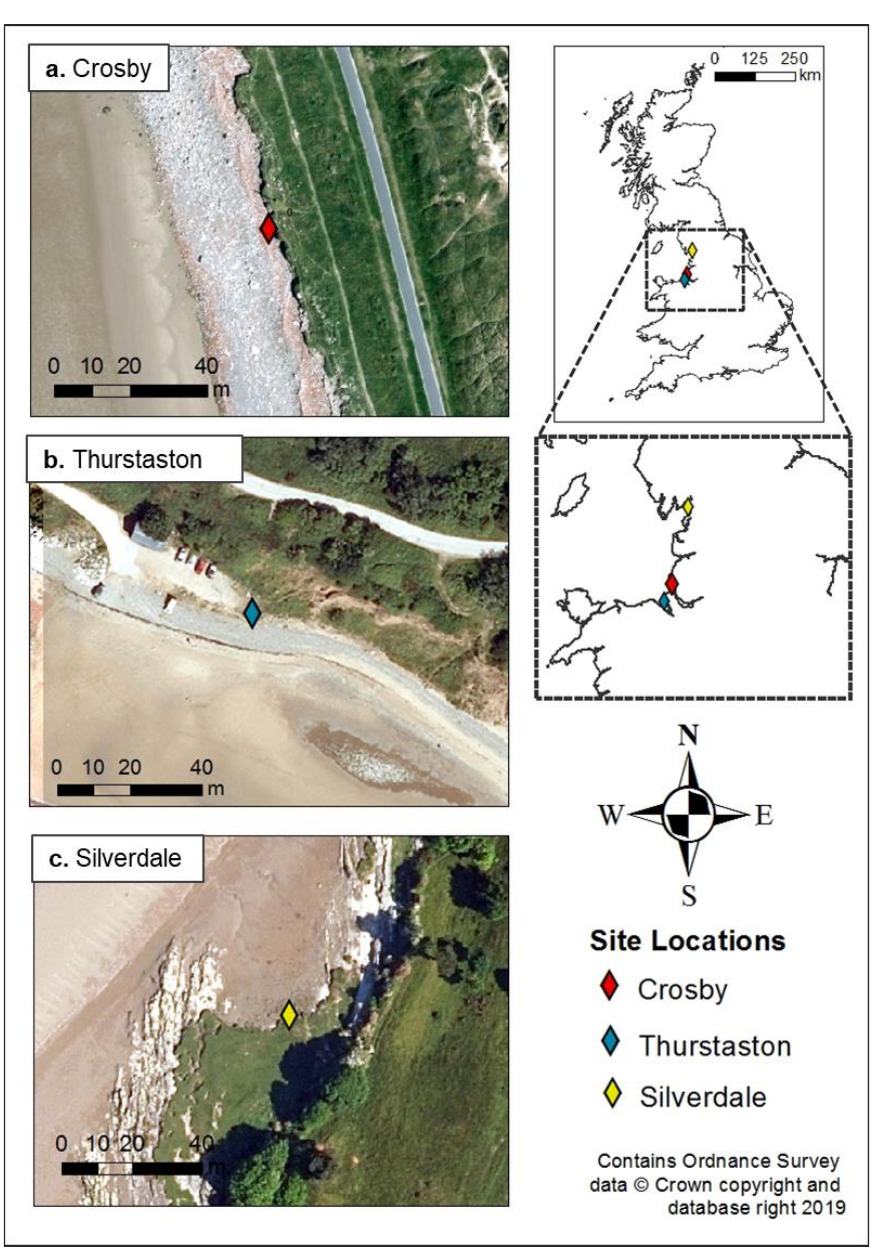
Figure 1. Locations and aerial images of Crosby ( a ), Thurstaston ( b ) and Silverdale ( c ) study